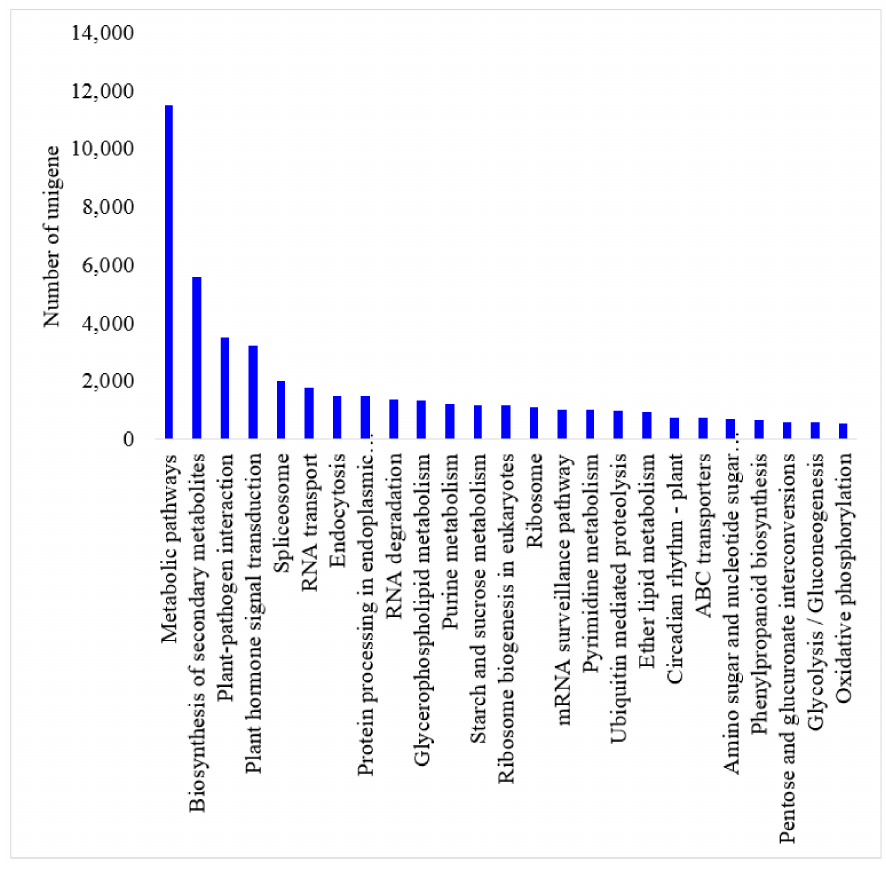
Figure 2. Top 25 pathways to which impatiens leaf transcriptomes were mapped using the Kyoto Encyclopedia of Genes and Genome Database